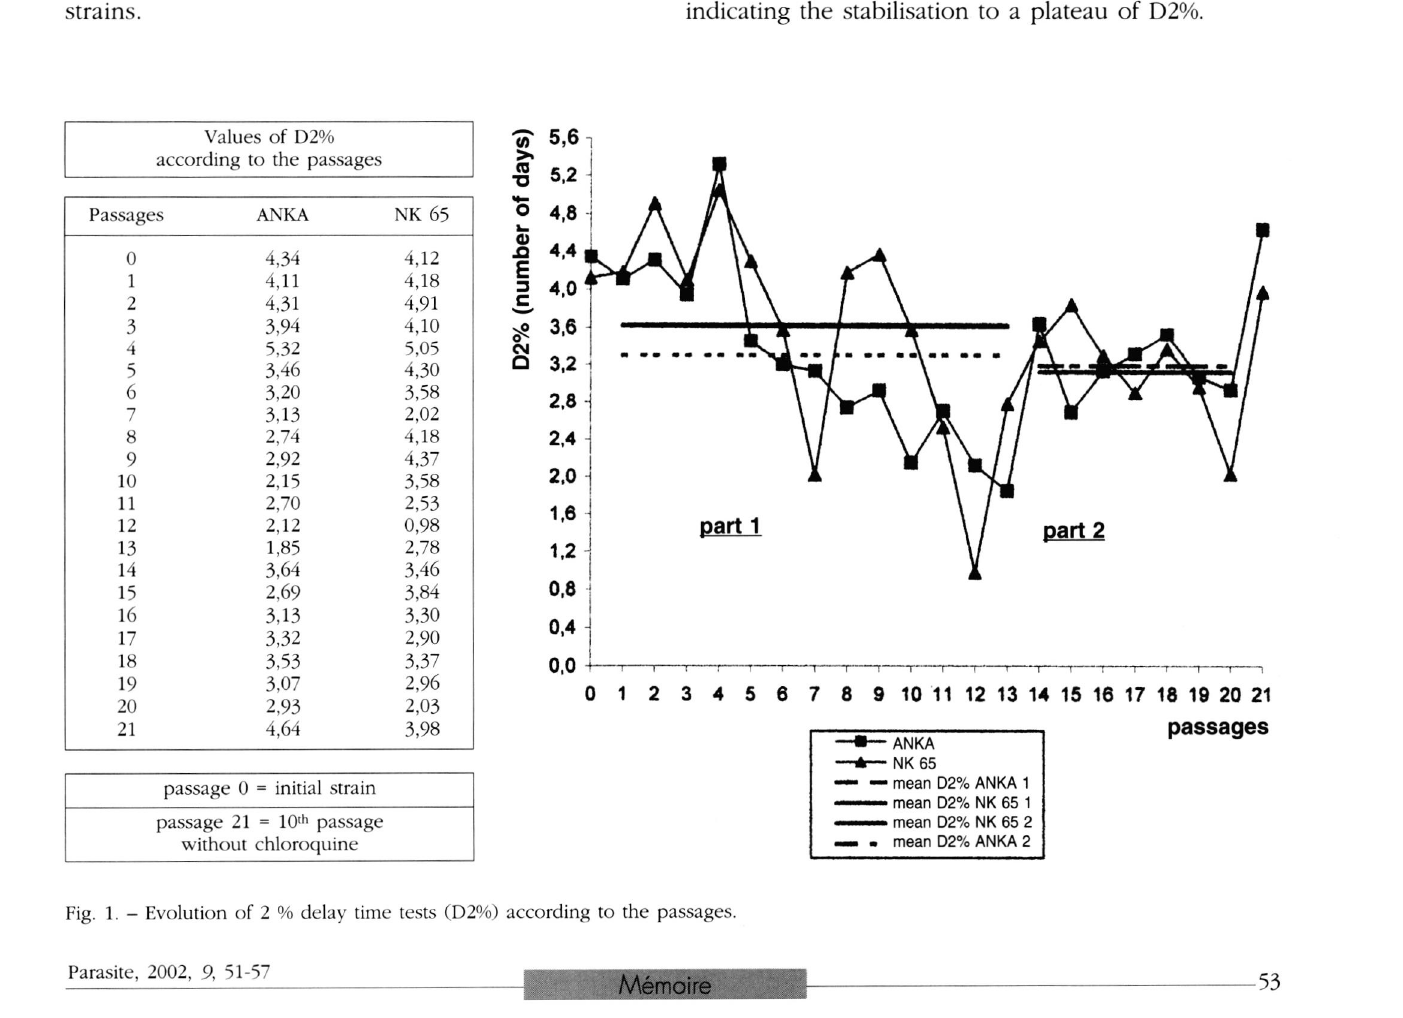
Fig. 1. - F.volution of 2 % delay time tests (D2%) according to the